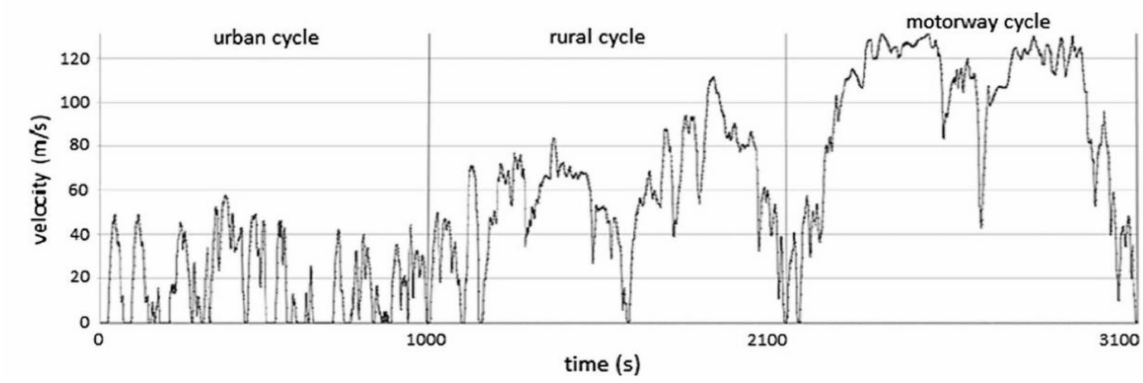
Figure 11. Common Artemis Driving Cycle for urban, rural and motorway with total duration of 3100 s and driving distance of 50,878 m. Adapted from ref.